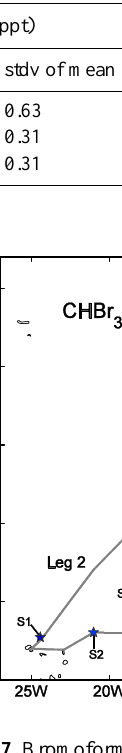
Fig. 6. Relative humidity cross sections [%] from radiosoundings Fig. 6: Relative humidity cross sections [%] from radiosoundings for the whole cruise. The 689 for the whole cruise. The subjectively determined MABL height subjectively determined MABL height [km] is marked by the black line. The measurement 690 [km] is marked by the black line. The measurement gap between leg 2 and 3 is shortened. gap between leg 2 and 3 is shortened. 691